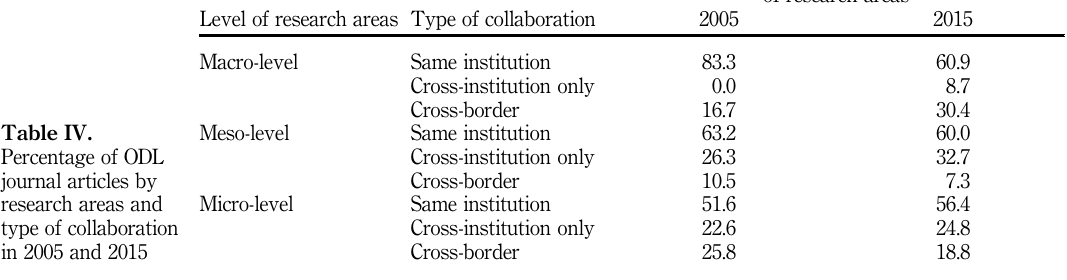
Table III. Percentage of ODL journal articles by type of collaboration in 2005 and 2015